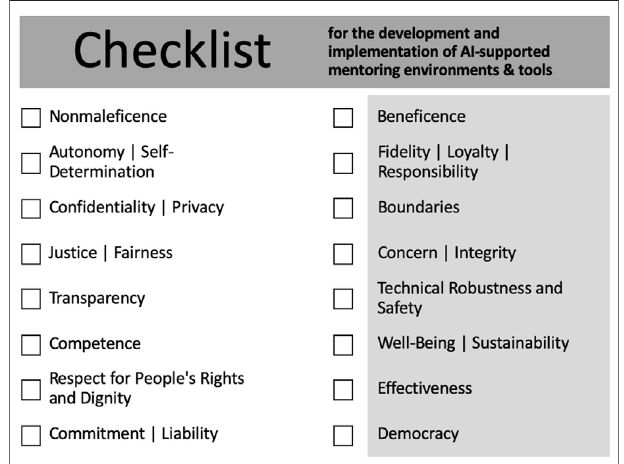
FIGURE 2 | Checklist for the development and implementation of AI- supported mentoring environments and